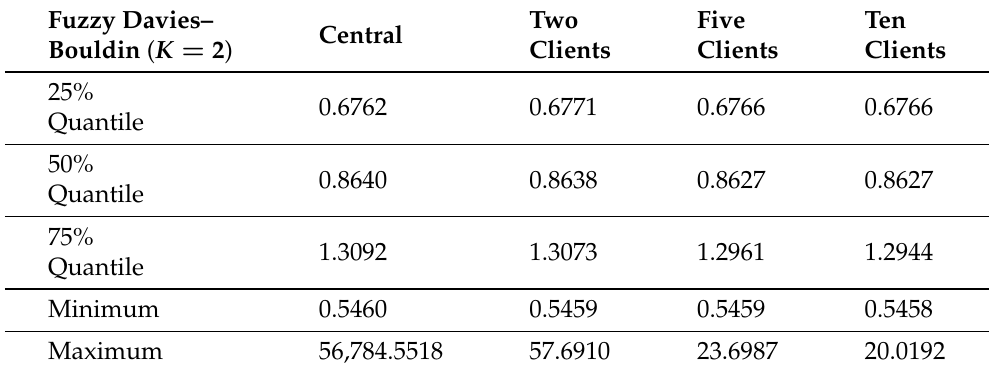
Table 4. Statistics of the (federated) fuzzy Davies–Bouldin index on 100 G2 test sets with k -means av- eraging.